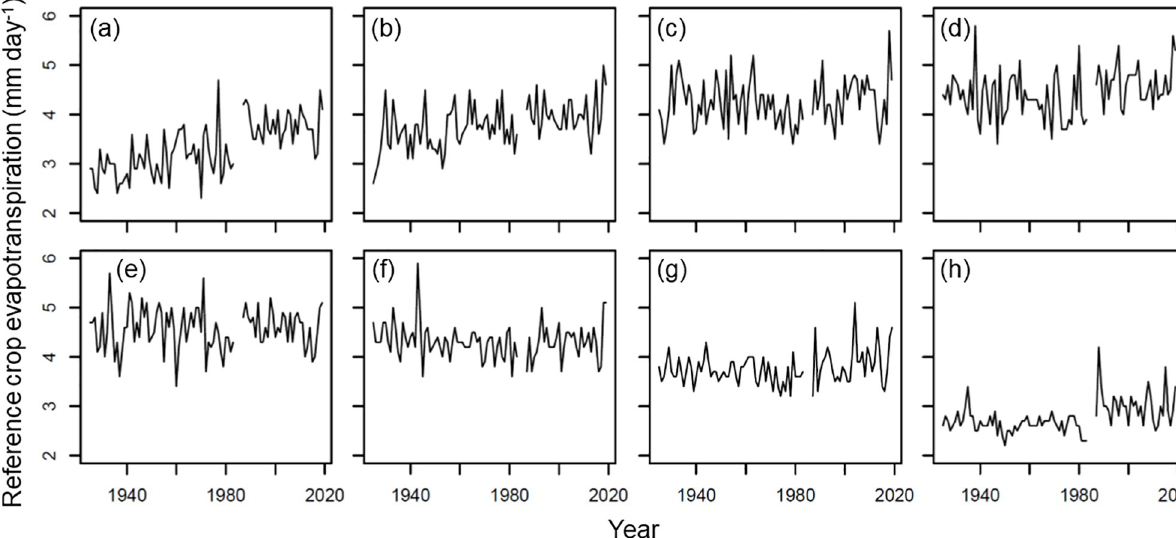
Fig 2. Yearly variation in reference evapotranspiration under initial (a and e), crop development (b and f), reproductive (c and g), and maturity (d and h) stages of rice in cool (a, b, c, and d) and warm (e, f, g, and h) cropping seasons.